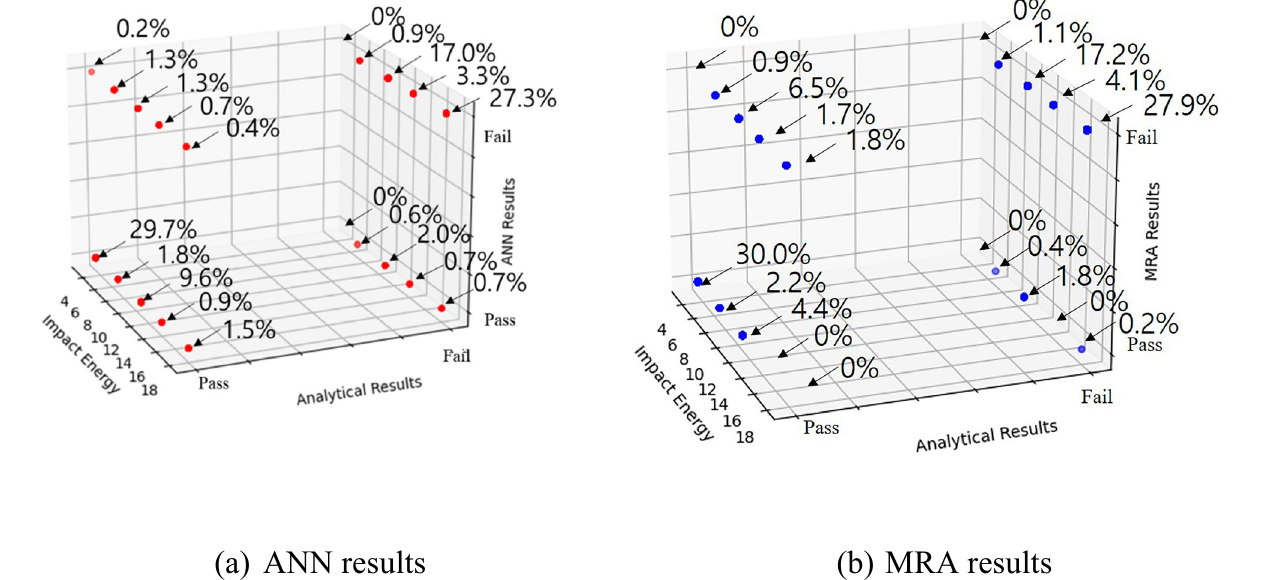
Figure 12. Comparison of the MRA and ANN results regarding fragments and travel